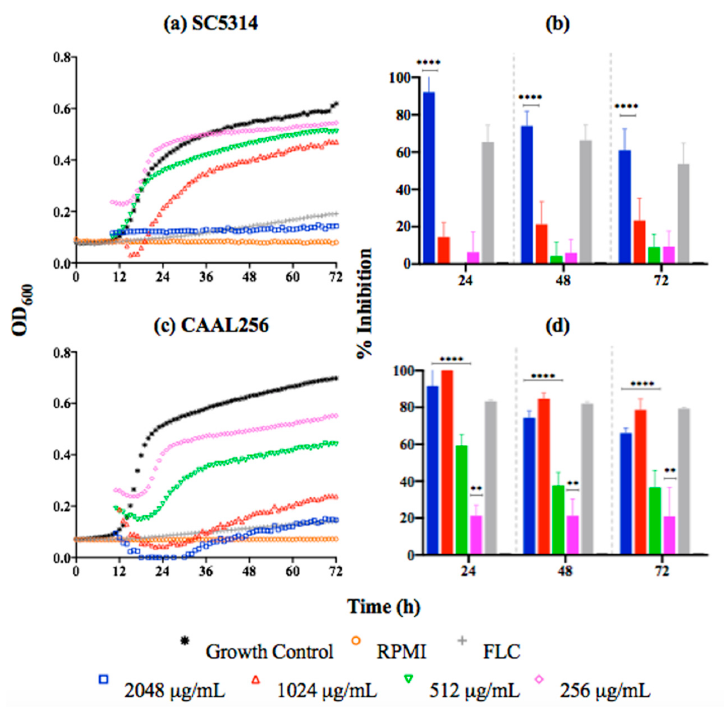
Figure 2. Time-kill kinetic curves of C. albicans strains exposed to P. nigrum ethanolic extract; ( a ) SC5314 kinetic growth (FLC concentration, 1.0 µg/mL), ( b ) percentage of inhibition. ( c ) CAAL256 kinetic growth (FLC concentration, 64 µg/mL), ( d ) percentage of inhibition. p -values of <0.05 were used to indicate statistical significance as follows: **** p < 0.0001, ** p < 0.0068.